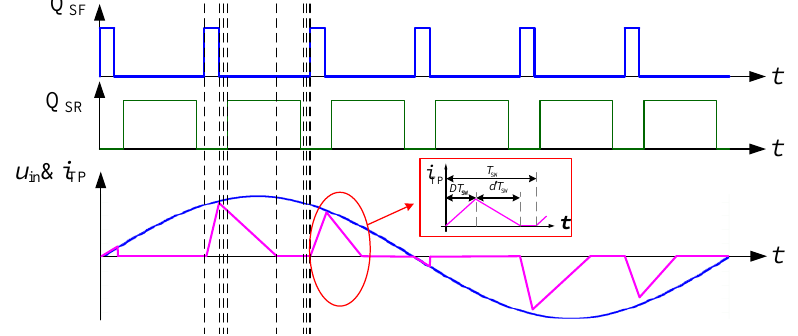
Figure 4. The operation waveforms of the PFC unit in steady state.